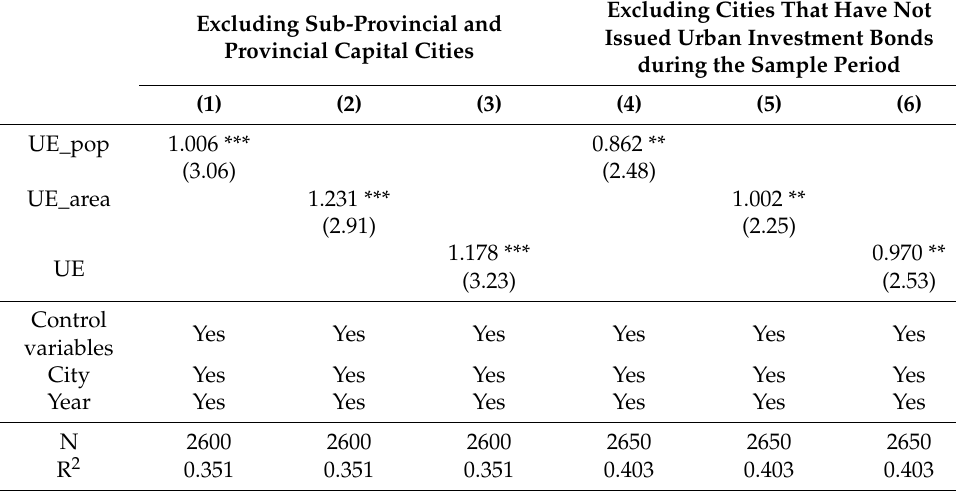
Table 4. Robustness test regression